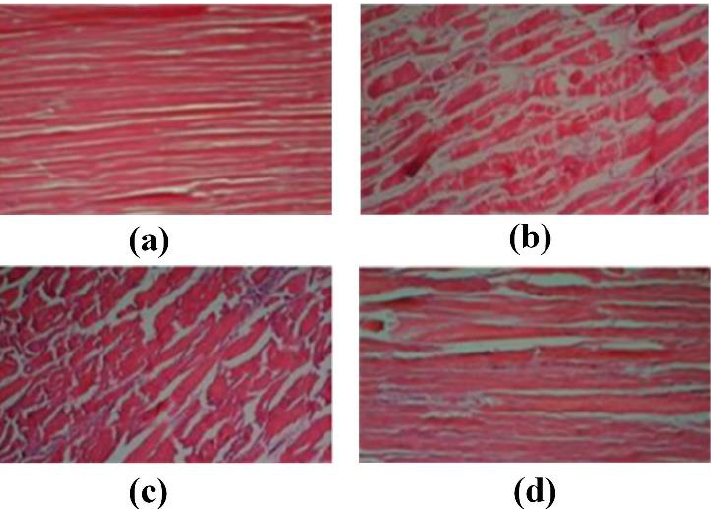
Figure 5. Sections of fresh chicken breast. ( a ) Thawed chicken breast by air method. ( b – d ) Thawed chicken breast by a high-voltage electrostatic field: ( b ) 1.5 kv/cm ( c ) 2.5 kv/cm ( d ) 3 kv/cm. Copyright